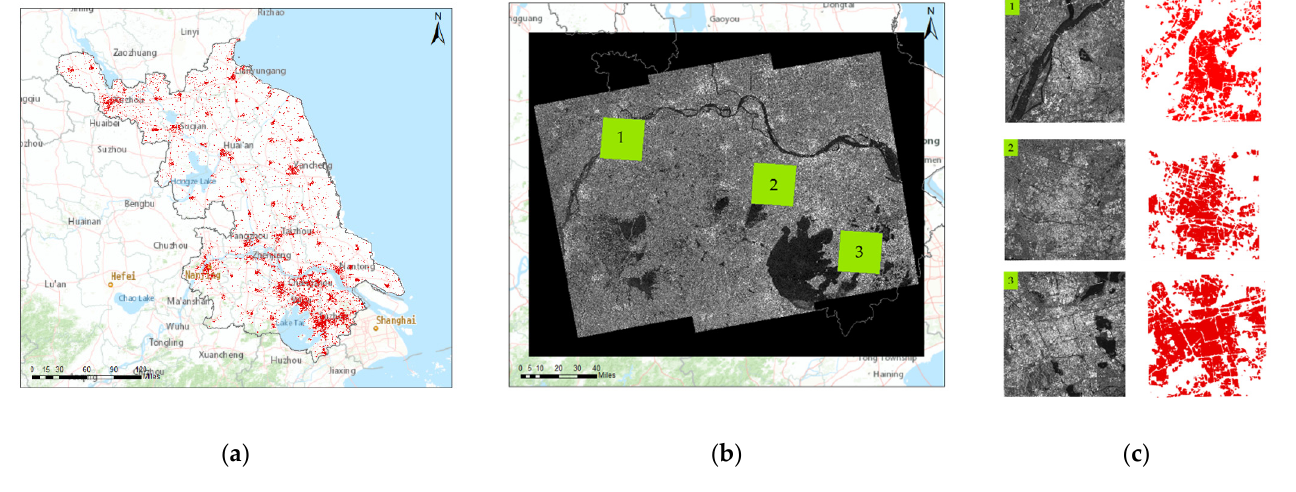
Figure 12. ( a ) The BA results of Jiangsu province using Sentinel-1 data, ( b ) SAR imagery of the three sub regions, and ( c ) the results in the three sub regions marked in ( b ). Table 6. Accuracy evaluation of BA extraction results in three sub regions.